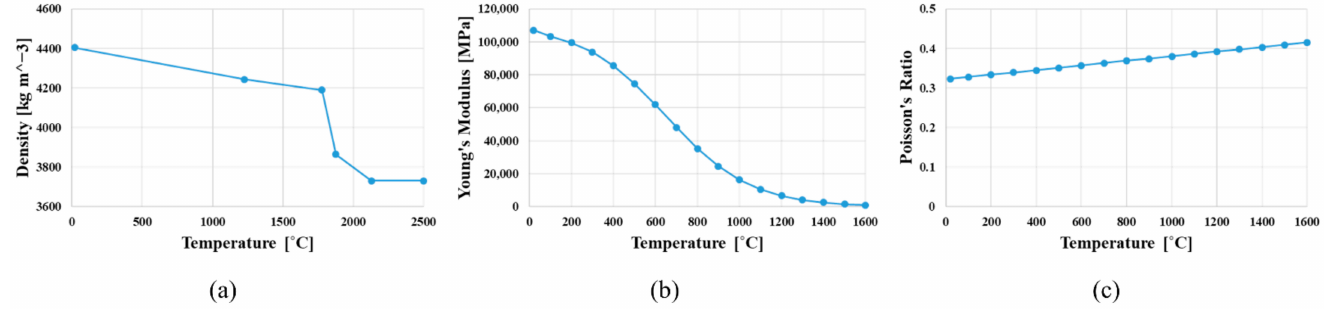
Figure 4. Properties of the Ti-6Al-4V: ( a ) density, ( b ) Young’s modulus, and ( c ) Poisson’s